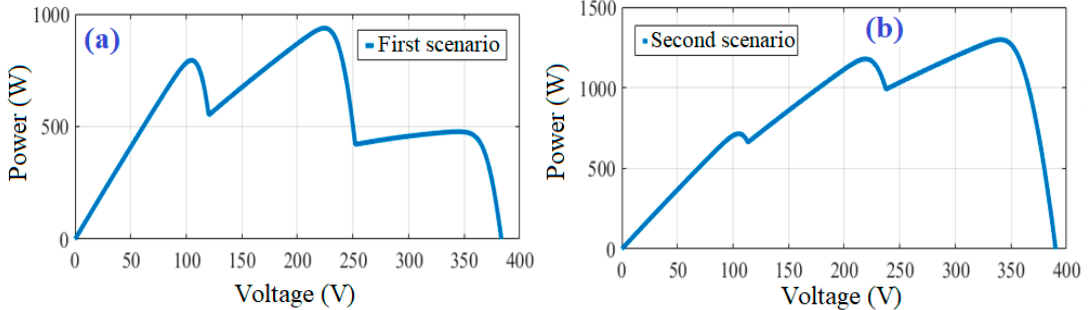
Figure 7. The P ‐ V graphs for each scenario ( a ) First shading scenario; ( b ) Second shading scenario.